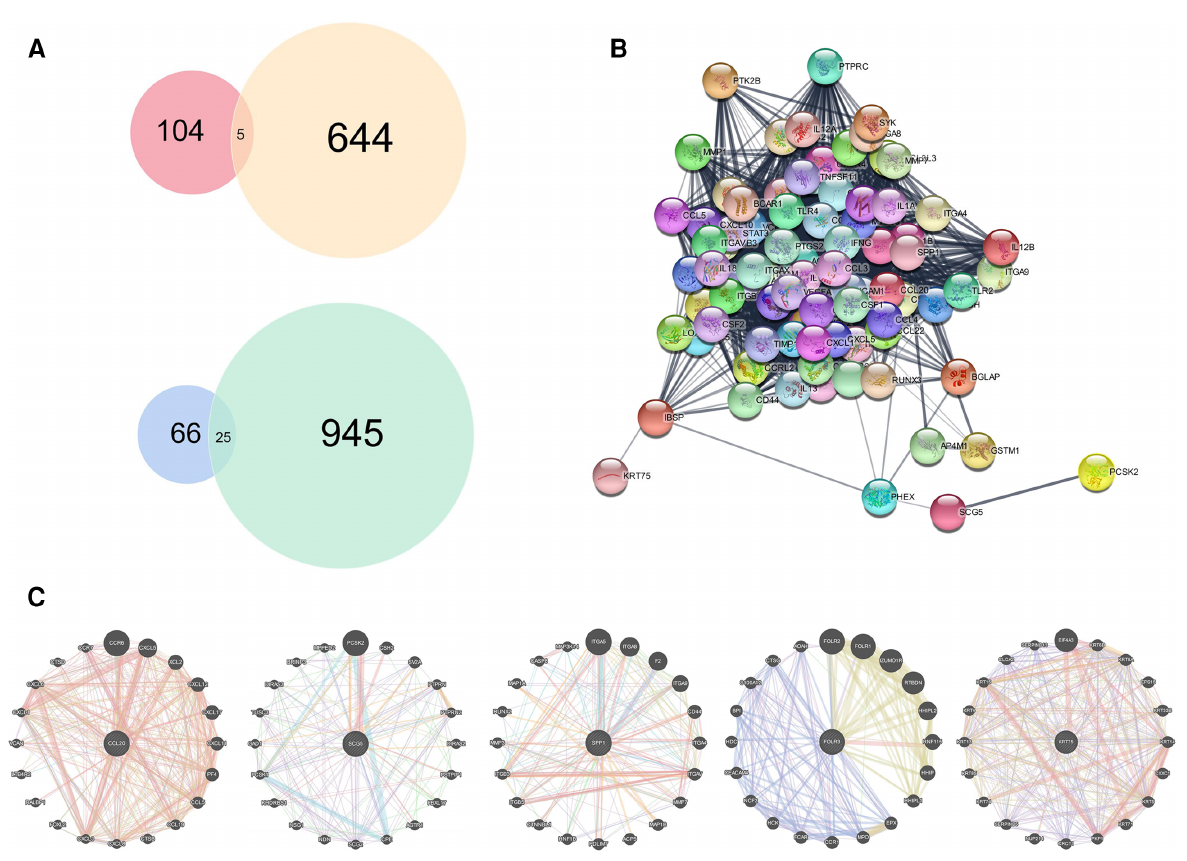
FIGURE 4 Acquisition and analysis of hub genes. DEGs obtained from GEO merged data set were combined with DEGs obtained from TCGA. ( A ) Venn diagram showing 5 common upregulated DEGs and 15 common downregulated DEGs. ( B ) Protein interaction network analysis of fi ve upregulated genes. ( C ) Functional analyses of the common upregulated DEGs